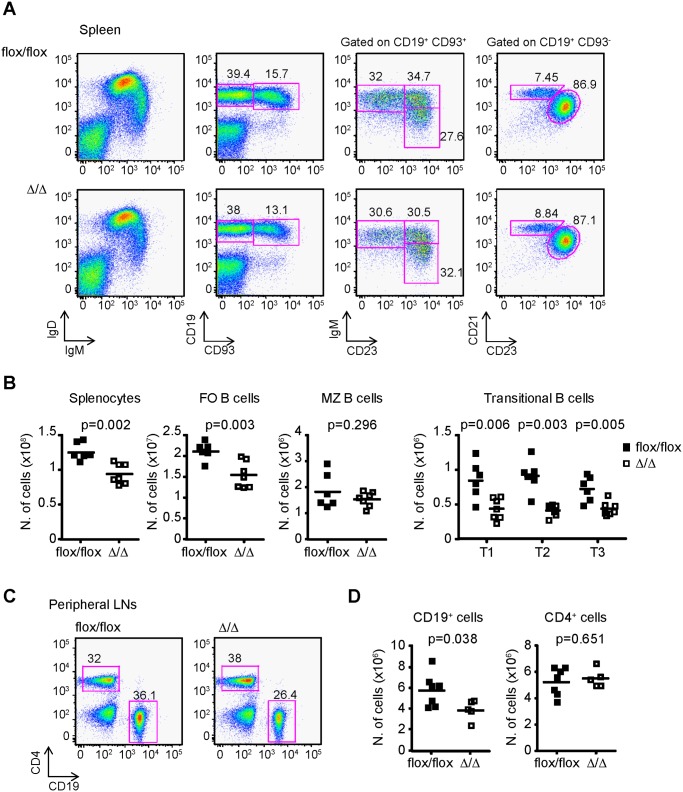
Bcl2-AREflox/flox x mb1cre mice have a reduced numbers of FO B cells in the periphery.
A, Flow cytometry analysis of FO B cells (CD19+ CD93- CD23+ CD21+ cells), MZ B cells (CD19+ CD93- CD23low CD21high cells) and transitional B cells (T1: CD19+ CD93+ IgM+ CD23- cells; T2: CD19+ CD93+ IgM+ CD23+ cells; and T3: CD19+ CD93+ IgMlow CD23+ cells cells) in spleens from Bcl2-AREflox/flox x mb1wt (flox/flox) and Bcl2-AREflox/flox x mb1cre (∆/∆) mice. N = 6/7 mice per genotype. The mean percentage of cells in each gate is shown in each representative plot. B, Quantification of the number of total splenocytes, FO B cells, MZ B cells, and transitional B cells, defined as described above. C, Analysis of CD19+ B cells and CD4+ T cells in peripheral LN (inguinal, brachial and axillary LNs were pooled together for the analysis). The mean percentage of cells in each gate is shown in the plots. N = 5–7 mice per genotype. D, Quantitation of the number of CD19+ B cells and CD4+ T cells. A Mann-Whitney test was performed for statistical analysis of the data. P values are shown for each cell population.